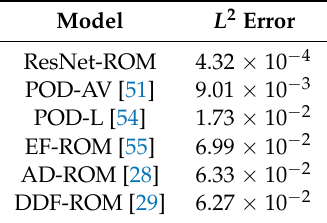
Table 1. L 2 errors of the new ResNet-ROM and other closure